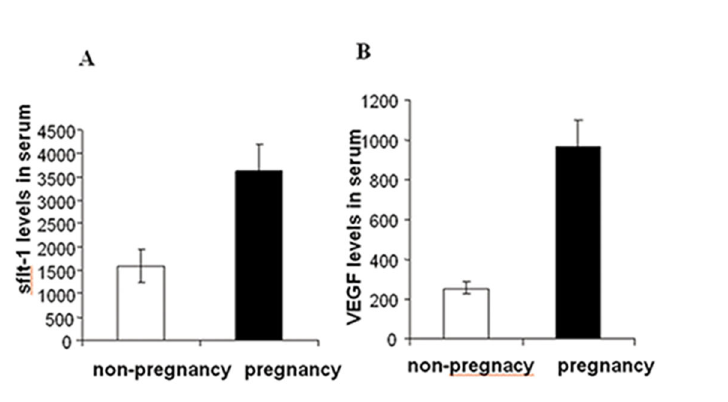
Figure 1. Levels of serum VEGF and sFlt-1 in pregnant and non-pregnant women. ( A ) The levels of sFlt-1 in women with normal pregnancies were significantly higher than in women that were not pregnant ( p <0.05). ( B ) The levels of VEGF in women with normal pregnancies were significantly higher than in women that were not pregnant ( p